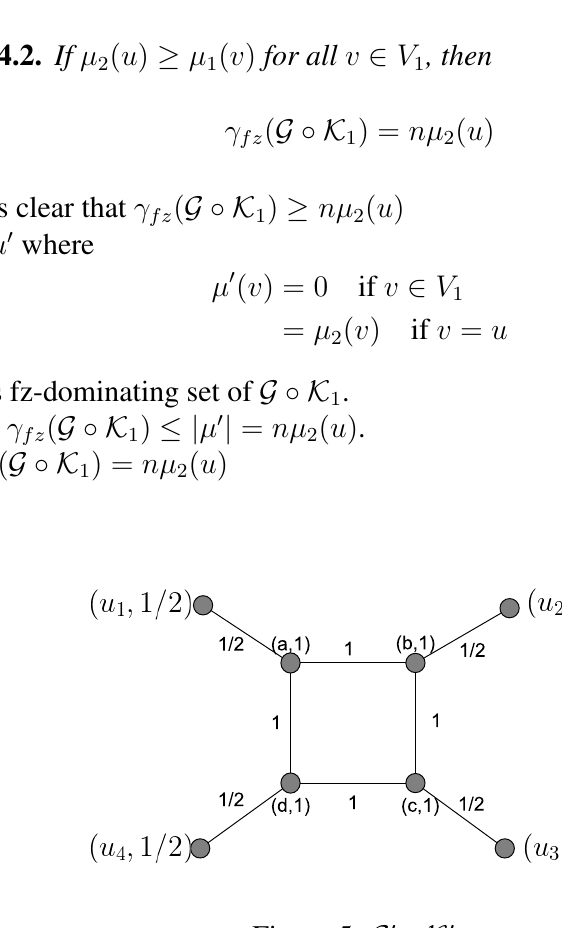
Figure 5: G (cid:48) ◦ K (cid:48)